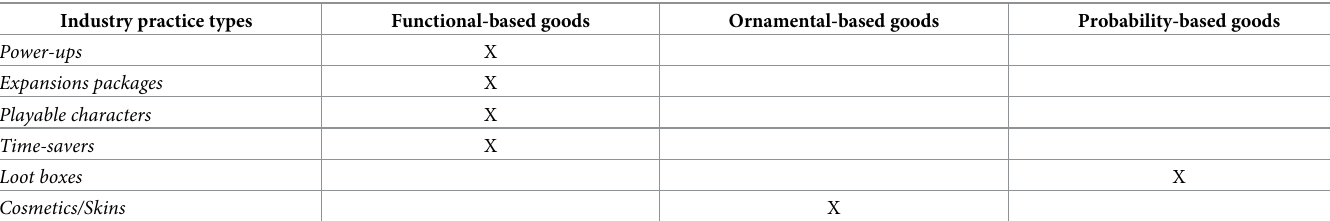
Table 1. Classification of in-game